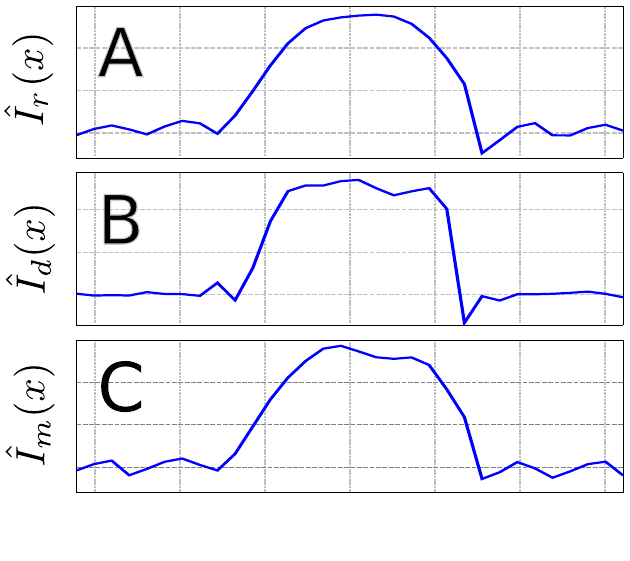
Figure 5. 1D profiles along the phase encoded dimension for a select point along the readout dimension for the NAA singlet at 2.0 ppm for the ( A ) regularly sampled; ( B ) doubly sampled; and ( C ) multi-echo sampled k -space